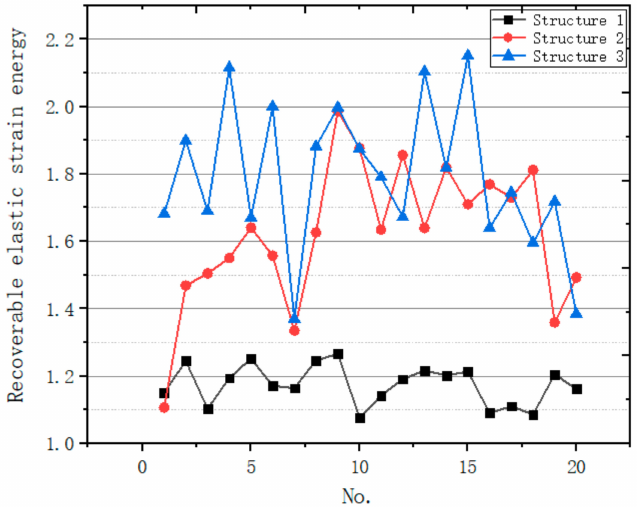
Figure 36. Comparison of recoverable elastic strain energy of three